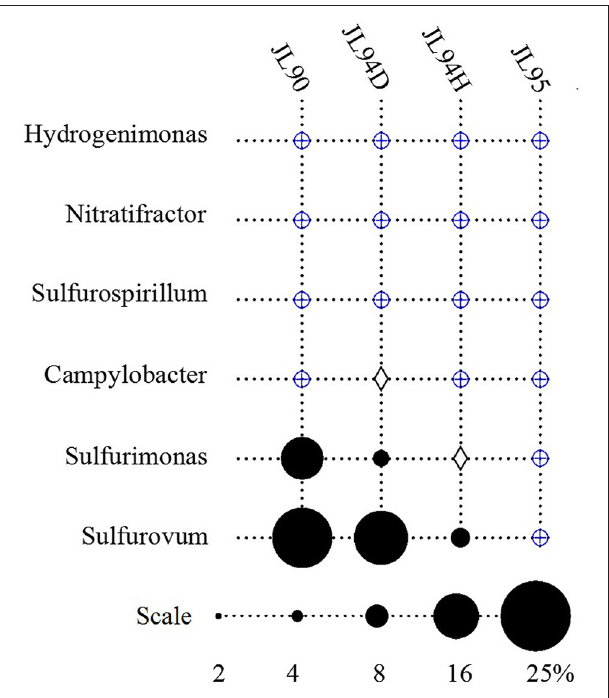
FIGURE 6 | Relative abundance of Epsilonproteobacteria genera observed in each chimney samplefor Longqi field at SWIR. Groups which were detected below1% are indicated with a blue oplus, between 1 and 2% are indicated with a